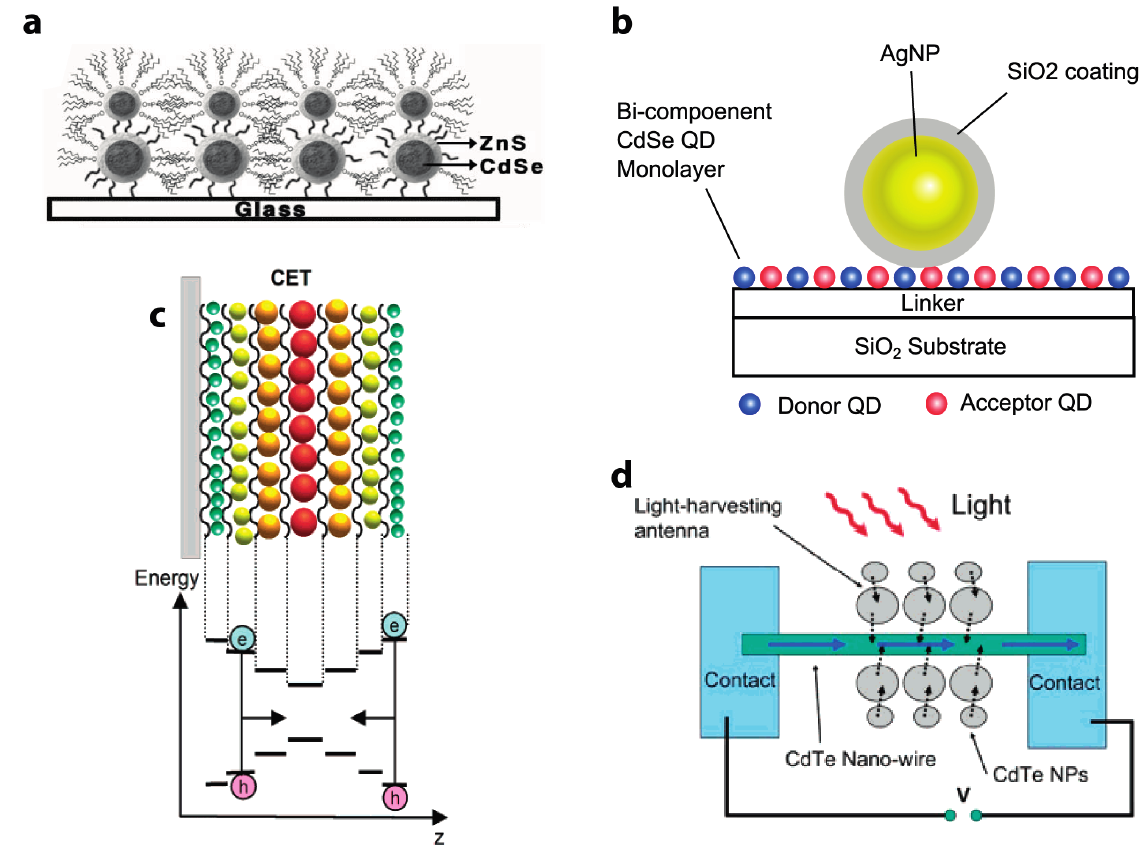
Figure 13. Schematics of QD-QD FRET nanostructures. ( a ) A bilayer structure made